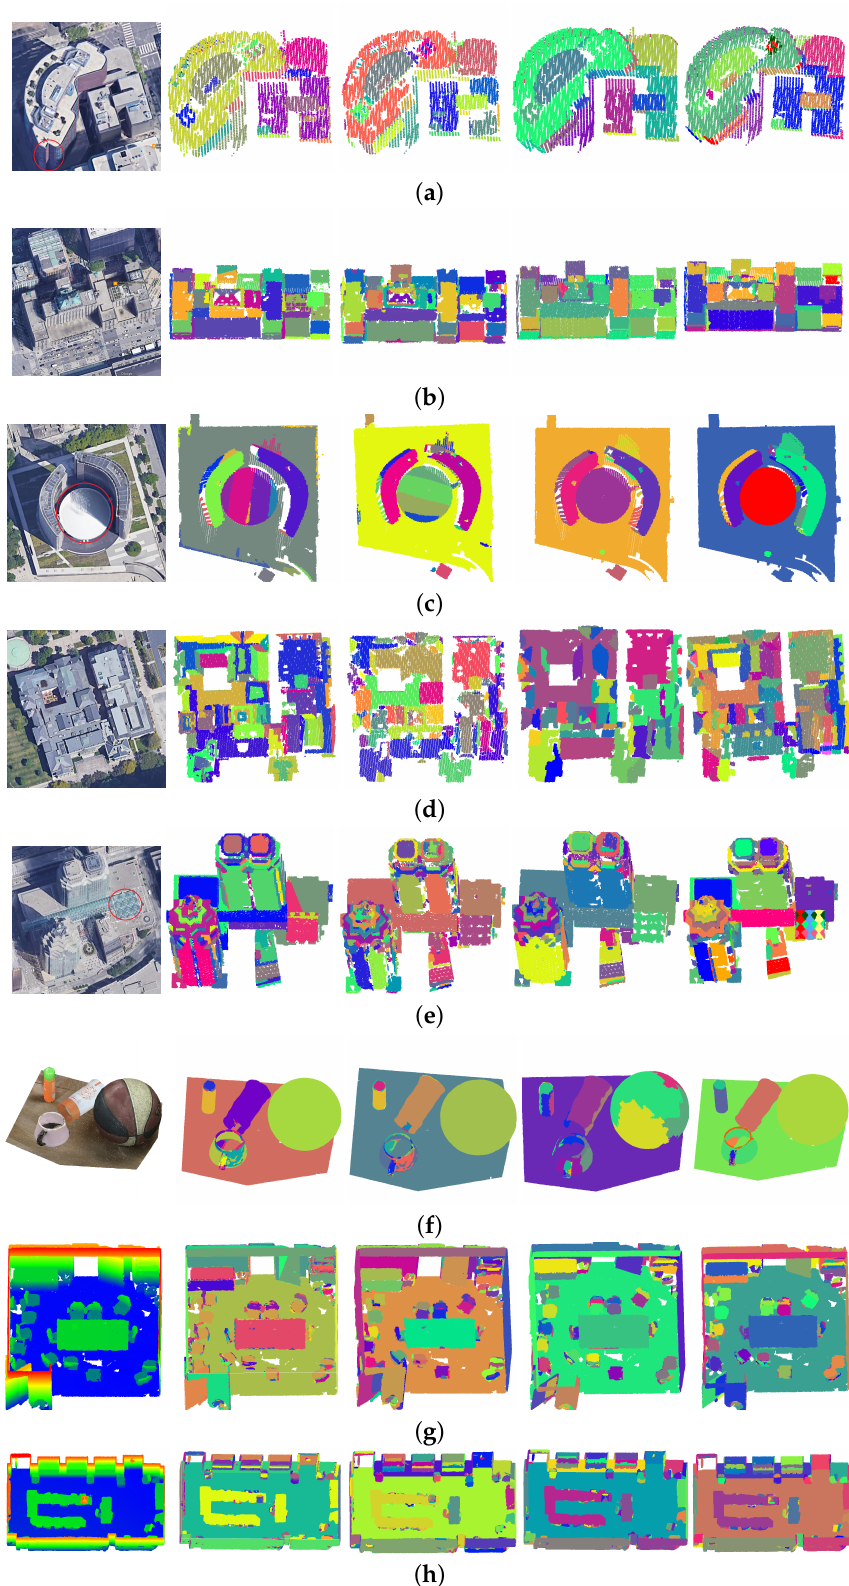
Figure 7. Segmentation details and comparison with the results of other research, from left to right: Google/input images; results obtained for efficient RANSAC, RG+efficient RANSAC, GlobalL0; and our final results. ( a – e ) are selected from the Toronto dataset, ( f ) and ( g , h ) are the segmentation results of Indoor scene 1 and 2,